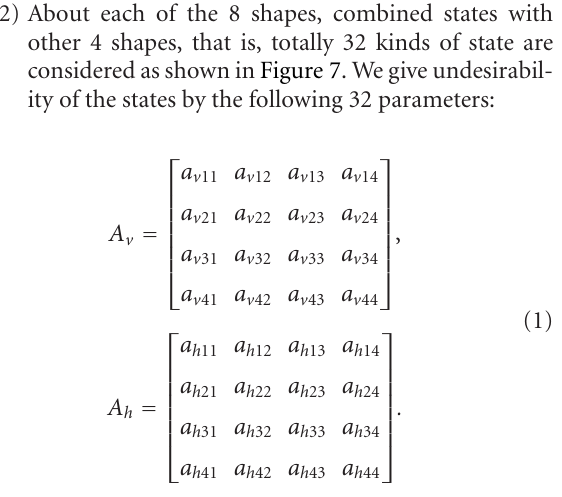
Figure 8. By repeating this process, CHOBIE II transforms to a configuration without undesirable local